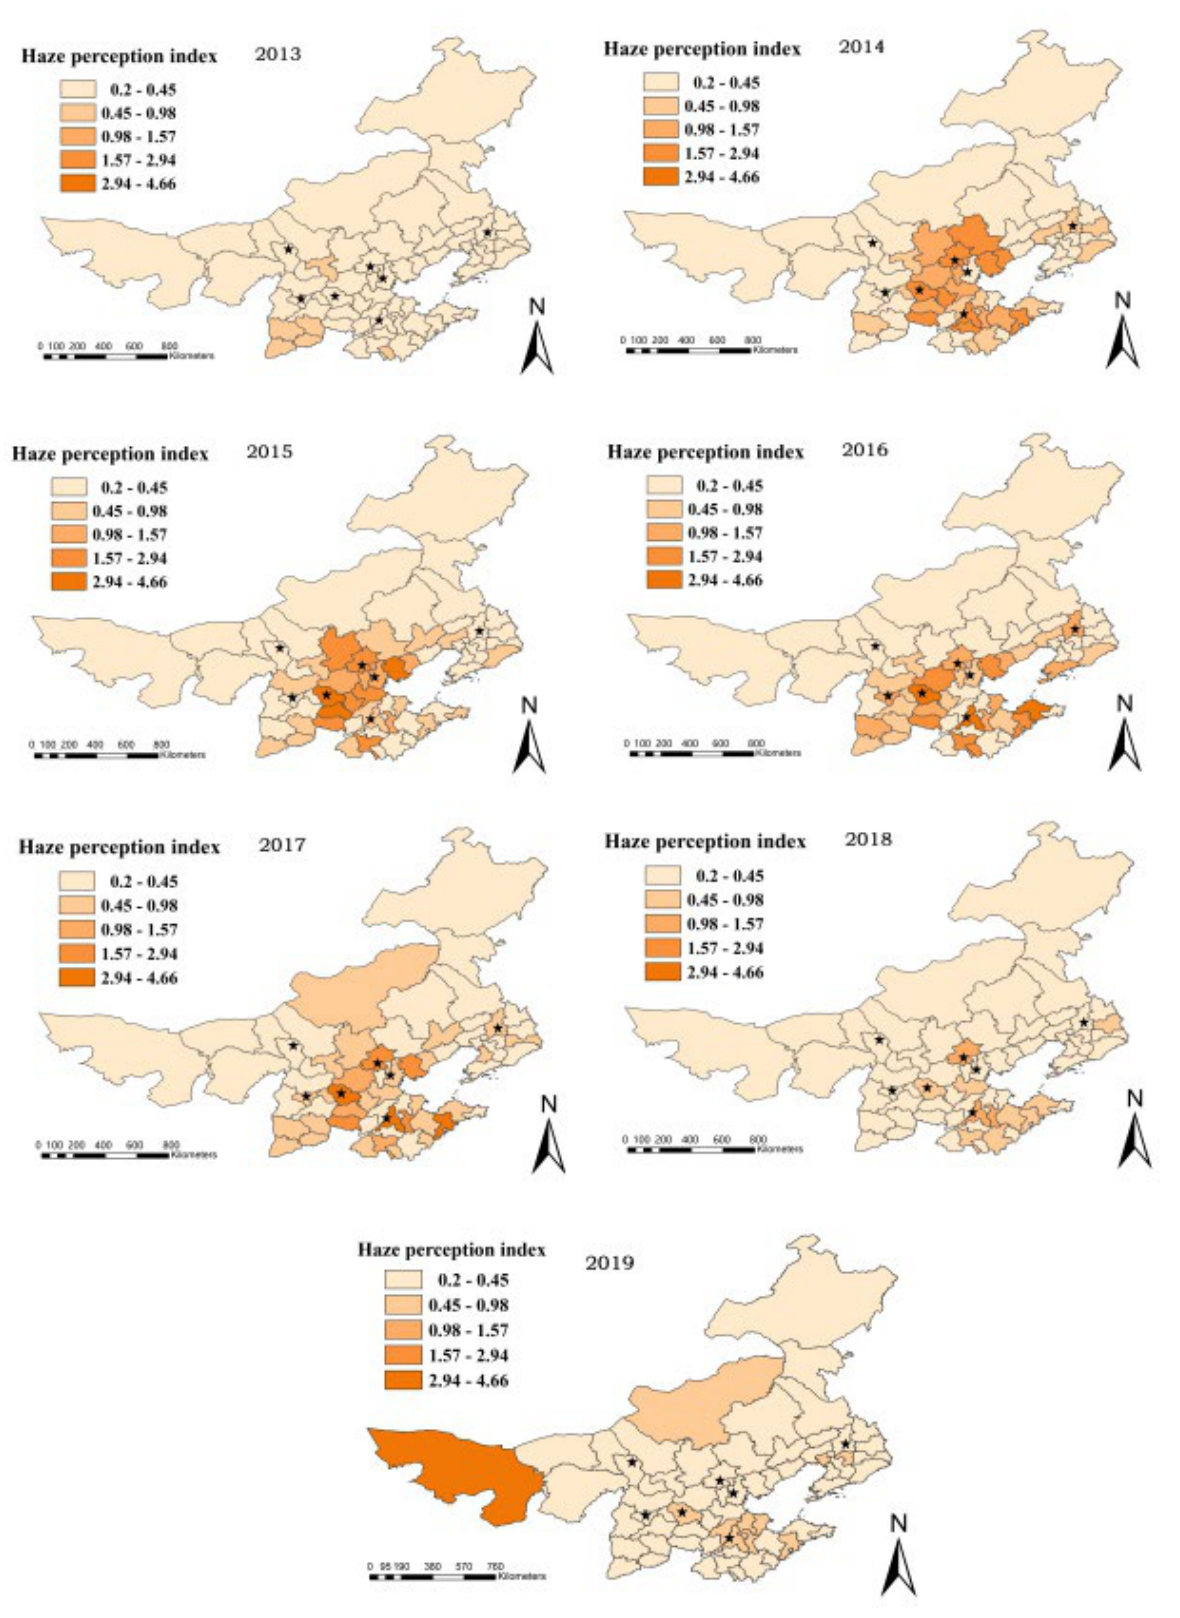
Figure 4. Perception of haze on a temporal and spatial scale. (The stars indicate the capitals of seven provinces).